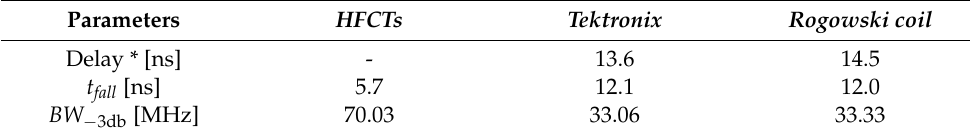
Table 4. Response parameters of the tested